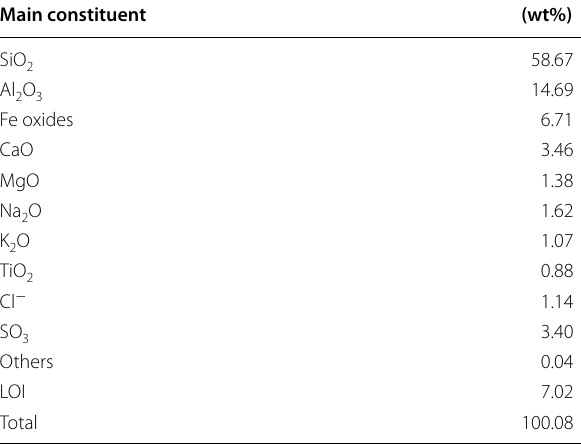
Table 4 Chemical analysis of the clay